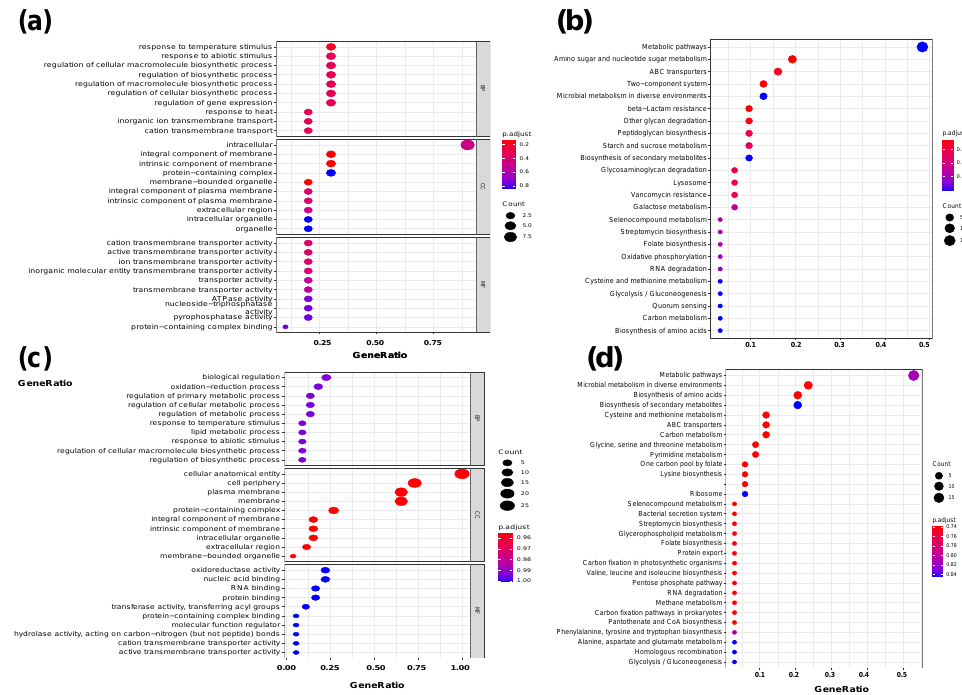
Figure 3. Function analysis of nonredundant DEGs during B. bifidum FHB150 biofilm formation. The GO terms analysis ( a ) and KEGG analysis ( b ) of DEGs between 22 h WF and 22 h C. GO: Gene Ontology. KEGG: Kyoto Encyclopedia of Genes and Genomes.The GO terms analysis ( c ) and KEGG analysis ( d ) of DEGs between 32 h B vs. 22 h B and 32 h P vs. 22 h